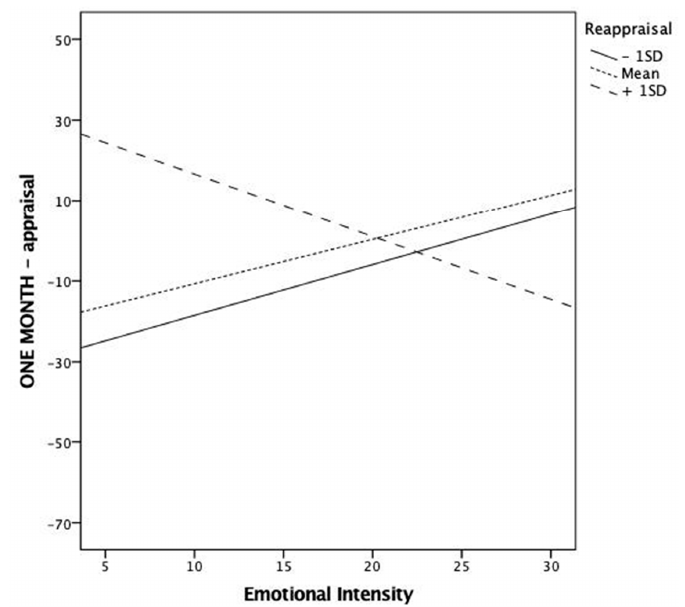
Figure 4. Graphical representation of the significant interaction between cognitive reappraisal and emotional intensity in predicting event appraisal at a one-month follow-up. Note that positive appraisal scores reflect the retrospective overes- timation of the negativity of the event, whereas negative values indicate the tendency to retrospectively underestimate it.